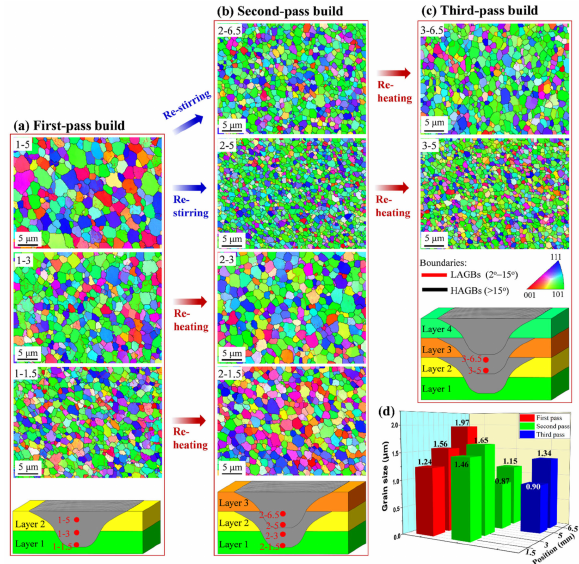
Figure 3. SEM-EBSD micrographs and stir zone illustrations of the ( a ) first-, ( b ) second-, and ( c ) third- pass builds; ( d ) average grain sizes in specified positions ( a – c ) are marked with red